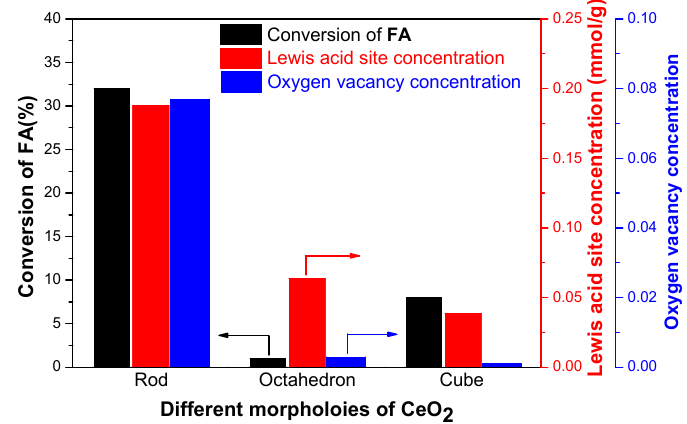
Figure 5. The relationship between the conversion of FA and the concentration of Lewis acid sites (unit: mmol/g) or the concentration of oxygen vacancies versus the CeO 2 with different morphologies.